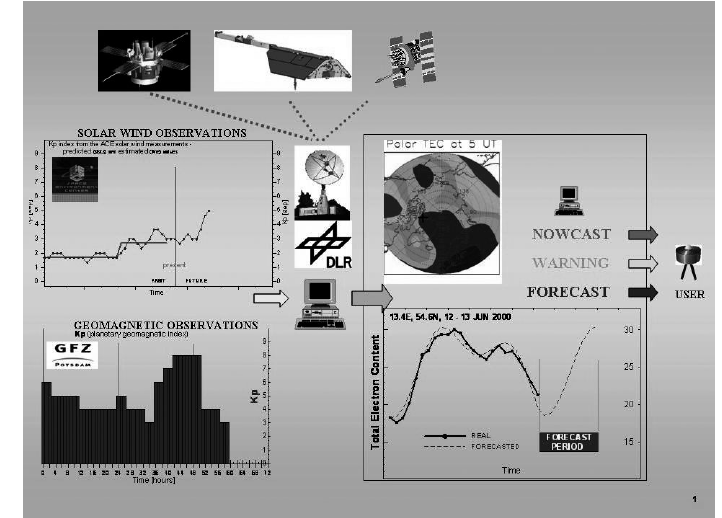
Fig. 16.10. A schematic view on the DLR/IKN nowcasting and forecasting